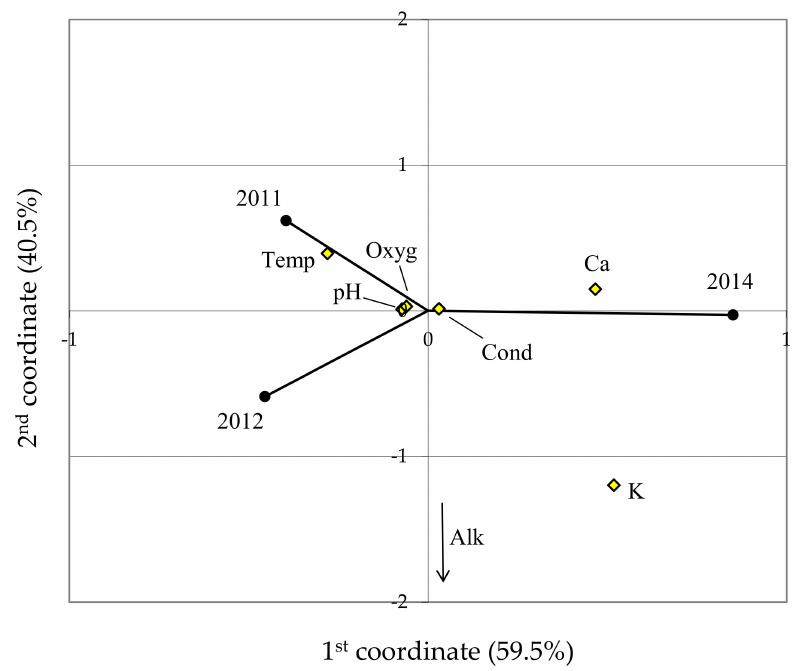
Figure 15. Position of selected years determined by selected physicochemical parameters and macroelements in the space of the first two canonical varieties and spacing of these parameters in the dual space (trait coordinates rescaled and divided by